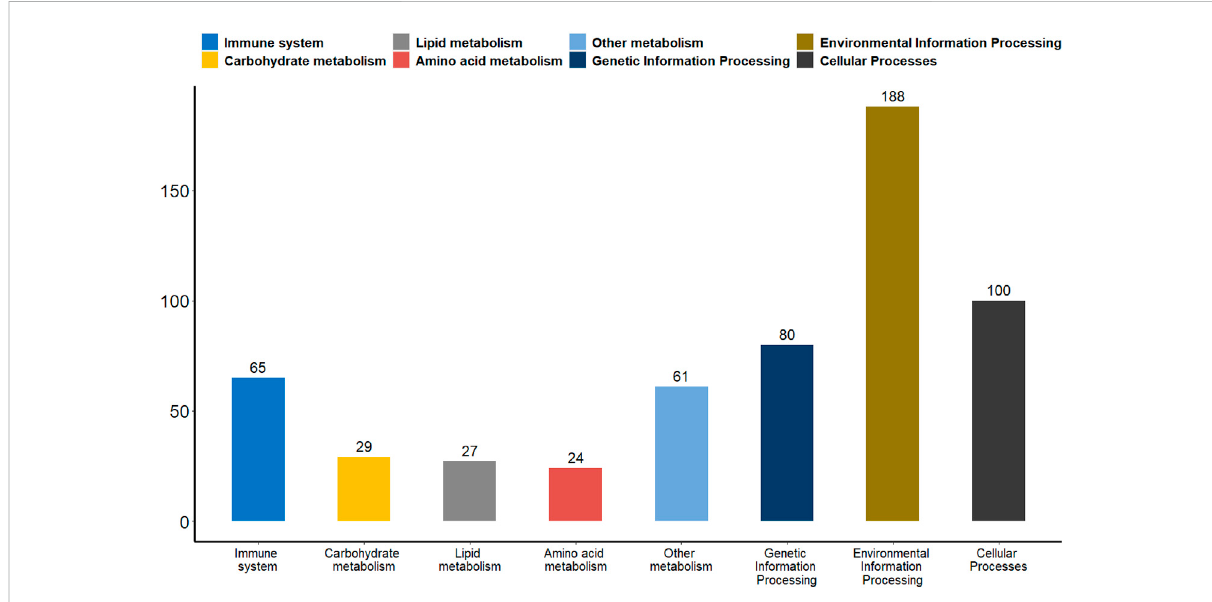
FIGURE 6 A bar plot of the functional annotation results of differentially methylated promoters. The X-axis represents the biological process on the annotation. The Y -axis represents the number of DMGs for a biological process on the annotation. We extracted only the immune system, carbohydrate metabolism, lipid metabolism, amino acid metabolism, metabolism of other substances, genetic information processes, environmental information processes and cellular processes for our presentations.